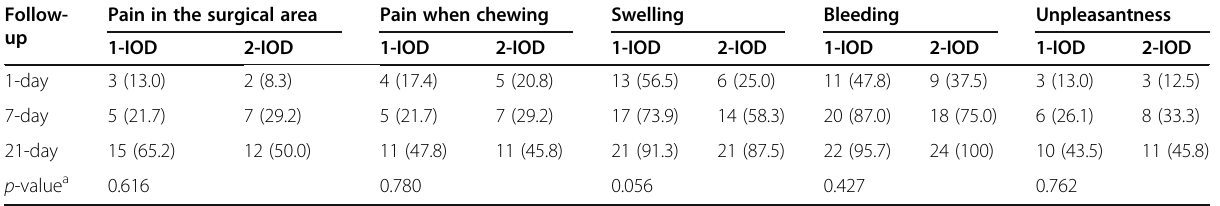
Table 4 Frequency distribution of the remission of symptoms (symptom score = 0), and tests of regression models for the treatment groups and follow-up as predictor variables Follow- up